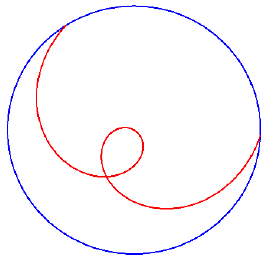
Figure 24. Motion trajectory of agglomerated particles with different magnetic field speeds.